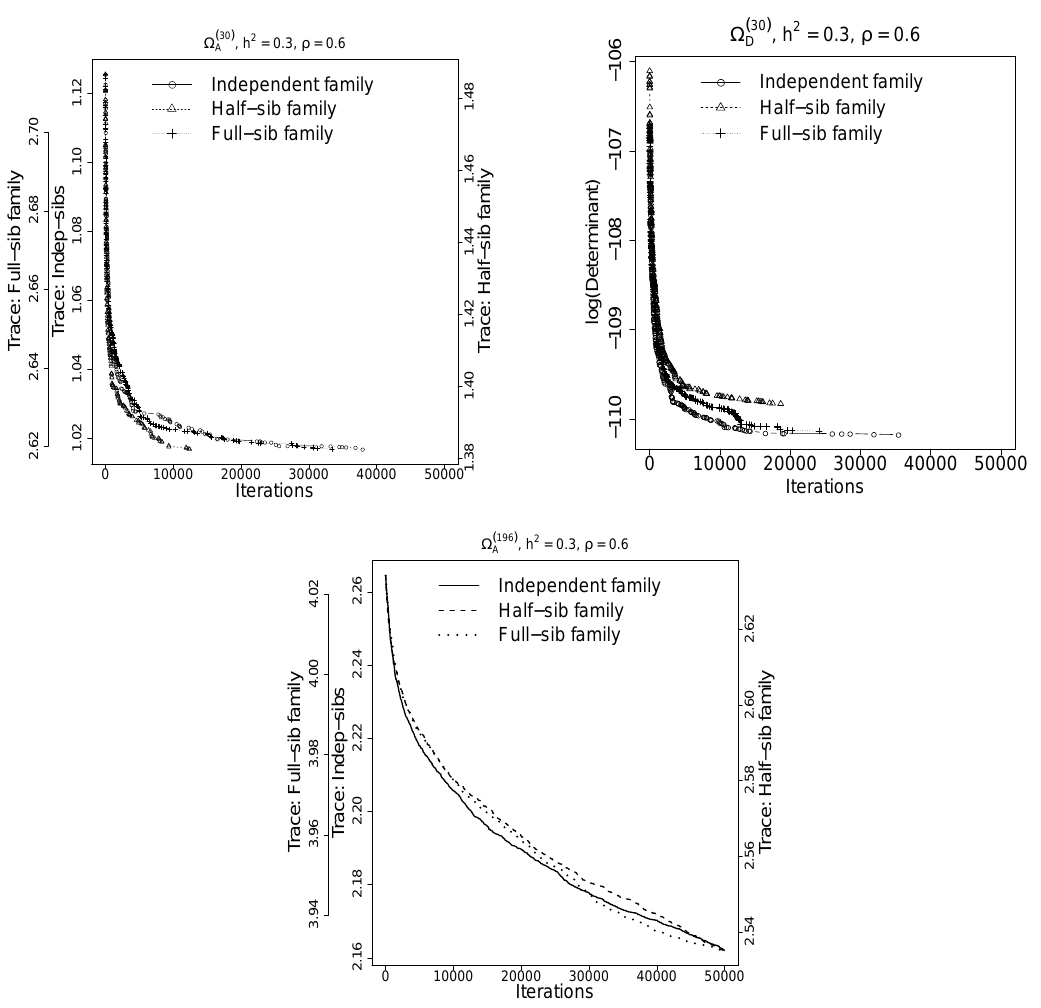
( 30 ) ( 30 ) ( 196 ) , (b) Ω , and (c) Ω based on h 2 = 0.3 D A A ( 196 ) had A